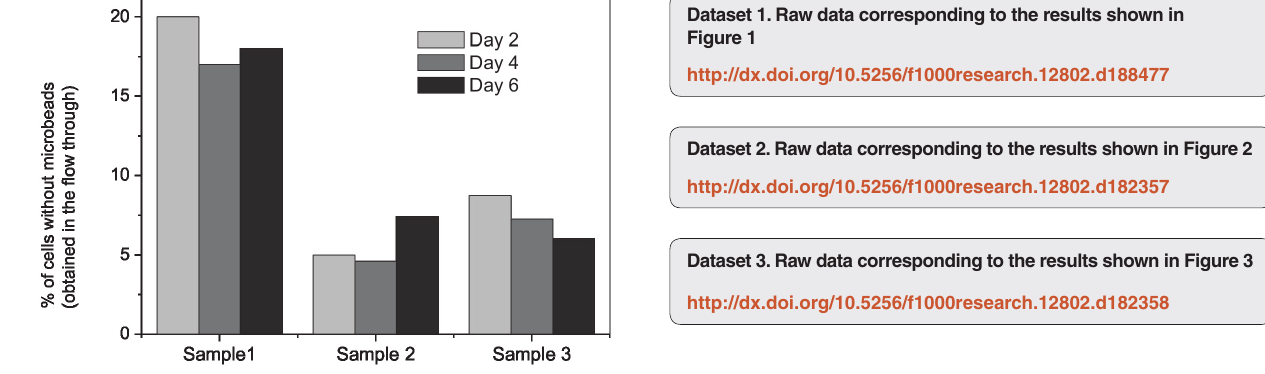
Figure 3. Variation in the percentages of CD14+ cells which do not have bound anti-CD14 microbeads when they were cultured for several